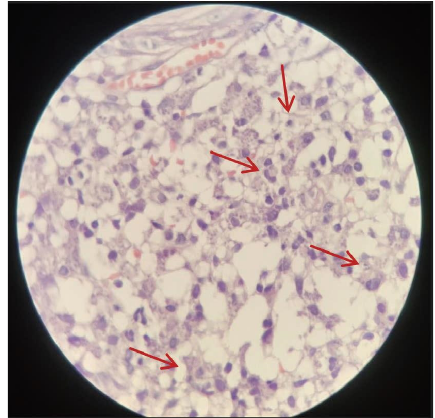
Figure 2: High power microscopy showing numerous foamy macrophages stufed with an intracellular parasite (arrow) along with other infammatory cells (H&E) case